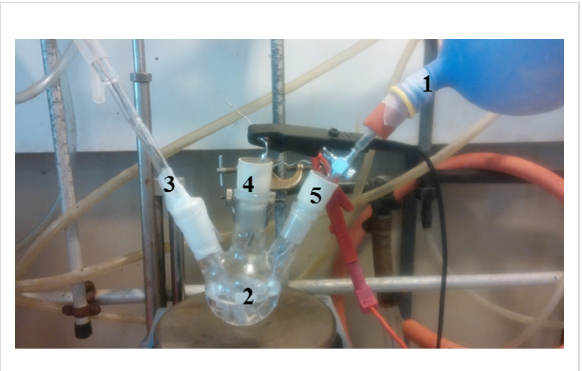
Figure 3: Single compartment three-electrode experiment. 1: Balloon of SF 6 , 2: electrochemical cell, 3: reference electrode (silver wire), 4: counter-electrode (platinum), 5: working electrode